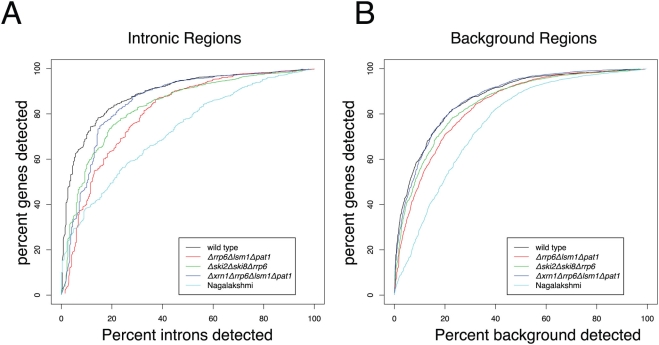
ROC-like curves depicting the relationship between the percentage of detected Verified ORFs and percentage of detected Intronic/Background regions, as the detection threshold varies.